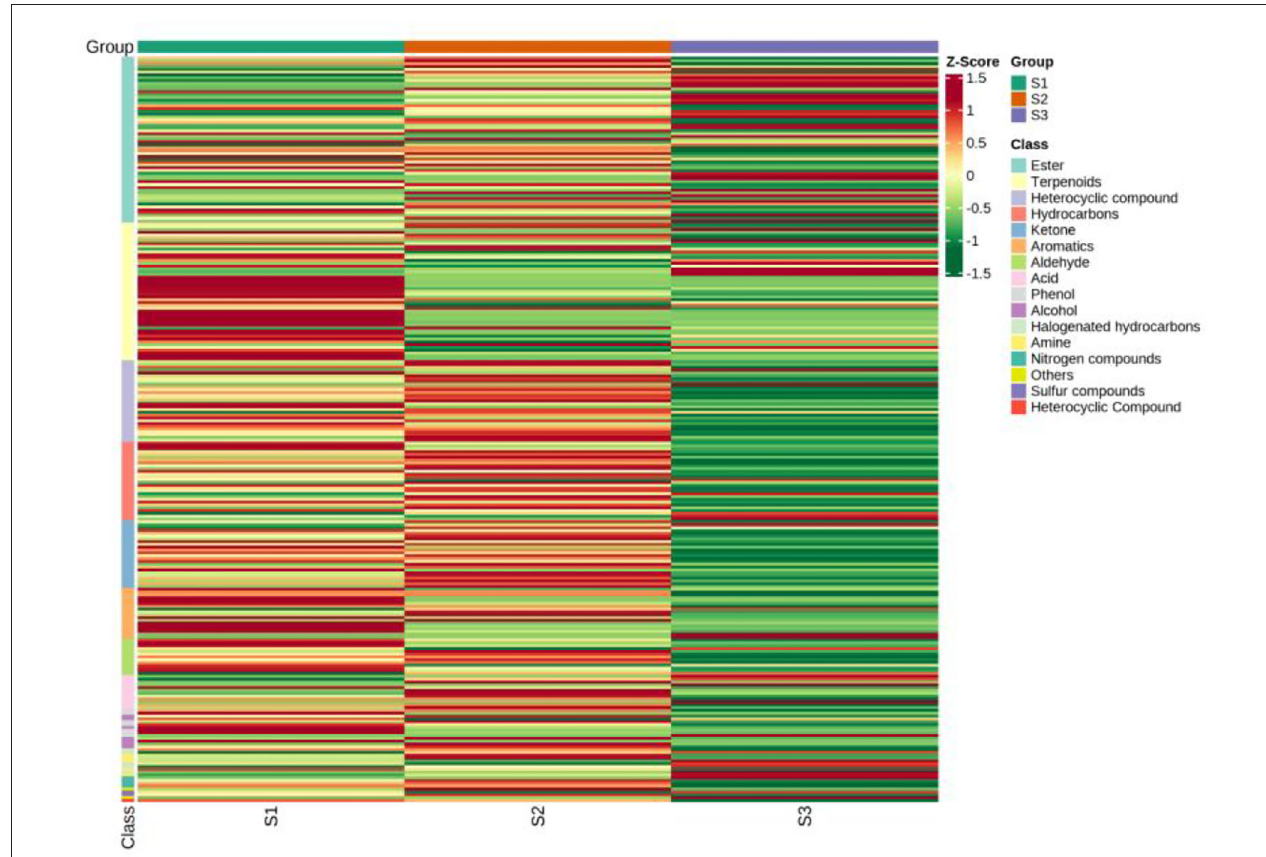
FIGURE 5 | Clustering heat map of all metabolites by classification and content by GC-MS. S1, the whole herbs in Pakistan; S2, the whole herbs in Lanzhou; S3, the seeds in